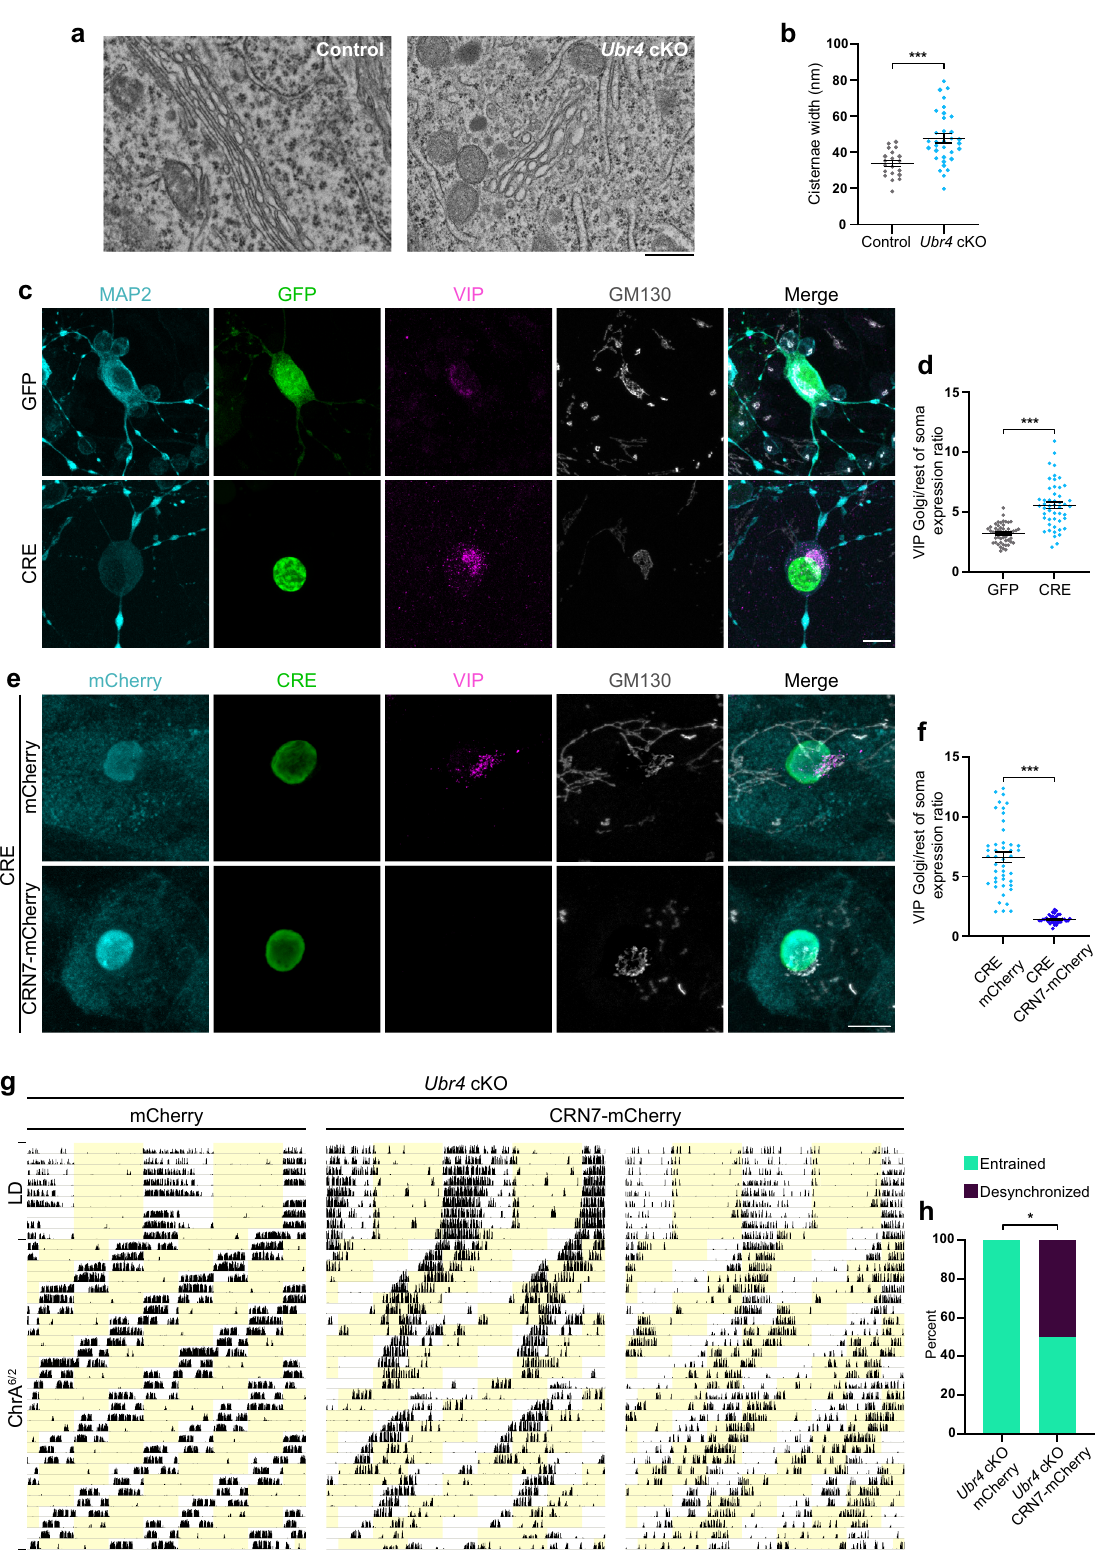
Sections were mounted onto gelatin-coated glass microscope slides, dehydrated, and coverslipped with Permount Mounting Medium. To visualize endogenous CD2-HRP expression in fl ies, following fi xation, adult fl y brains were rinsed in PBS (pH 7.4), washed 4× 20min in PBST (PBS, pH 7.4, with 0.3% Triton X-100) at RT, and then developed with the DAB HRP substrate according to the manufacturer ’ s instructions. For each experiment, all brains